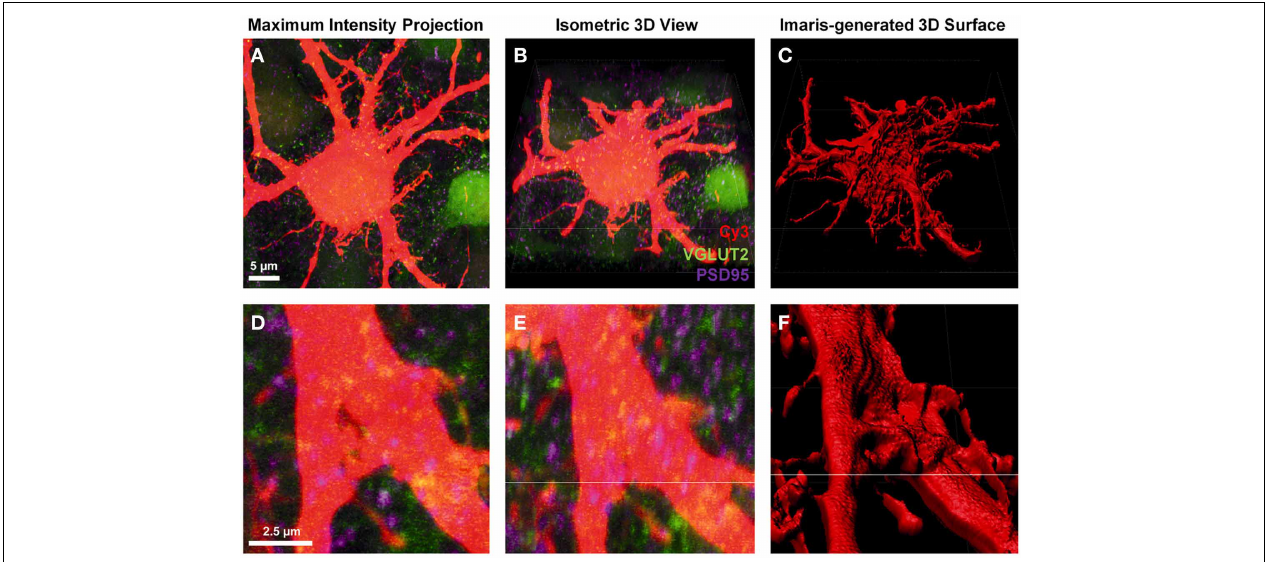
FIGURE 1 | Creating a neuronal surface. (A,D) show low and high magnification the maximum intensity projection of a Neurobiotin-filled hypoglossal motor neuron (Cy3) and excitatory synaptic components VGLUT2 (green) and PSD-95 (purple). (B,E) show low and high